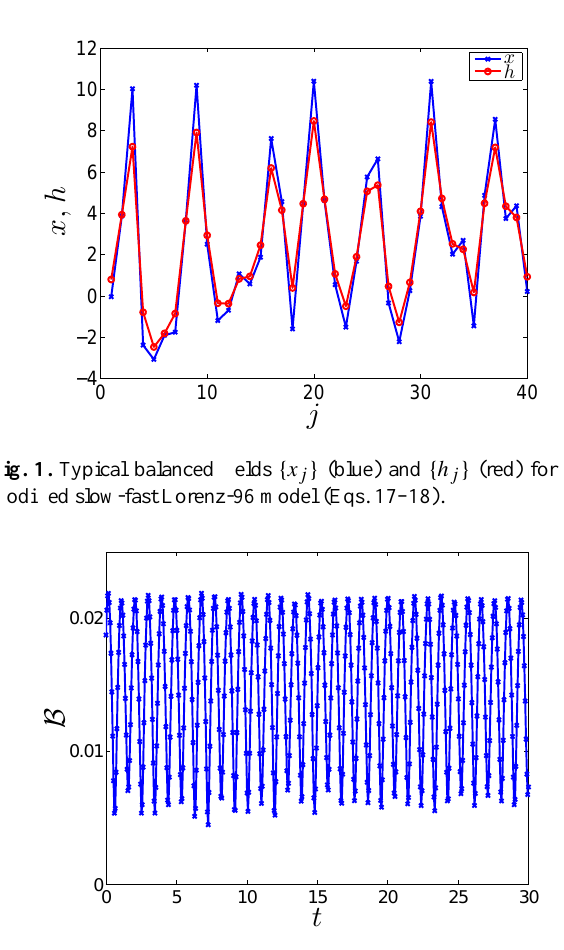
ε = 0.0025 and the “Burgers number” is set to α 2 = 0.25.